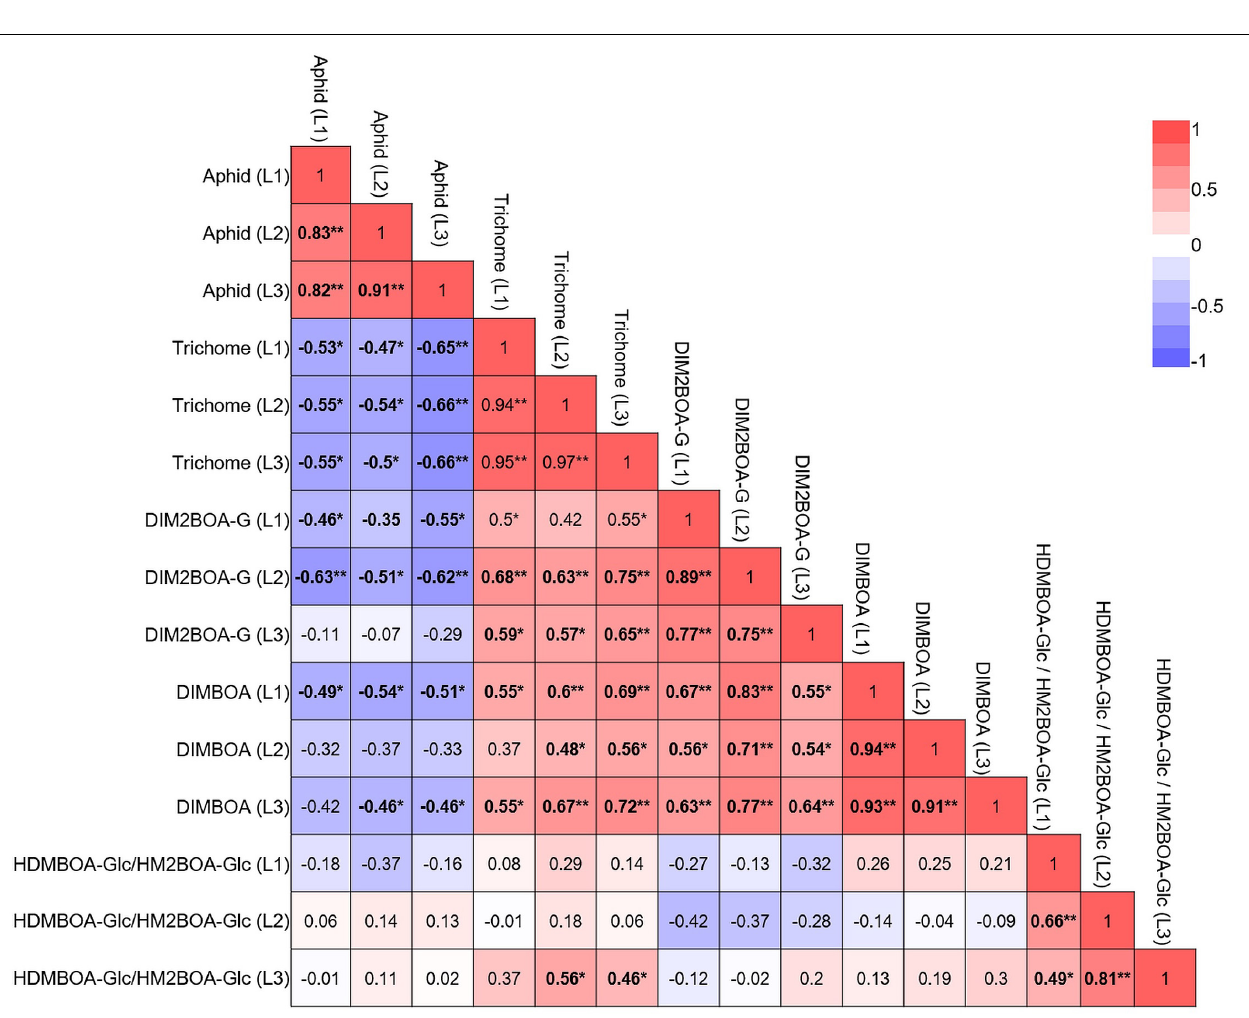
FIGURE 8 | Multivariate correlation between the plants’ physical and chemical defense. The constitutive and inducible data for plant defense were pooled together for correlation analysis. Red indicates a positive correlation, and blue indicates a negative correlation. * p < 0.05; ** p <